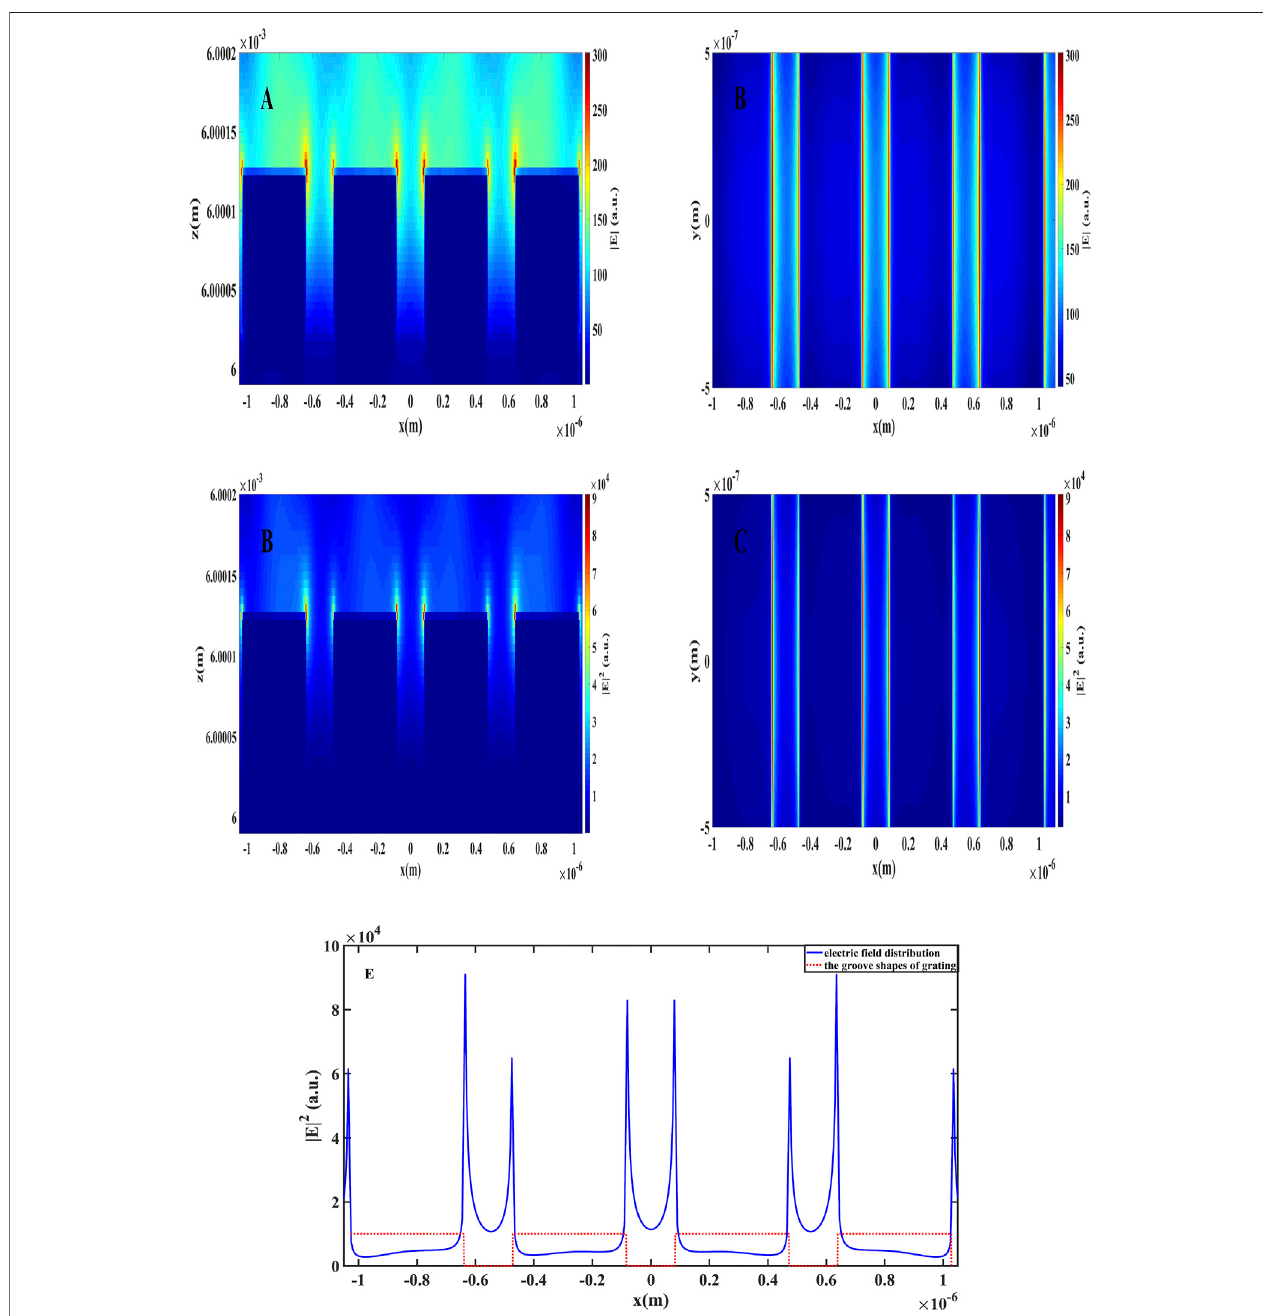
FIGURE 2 | Electric fi eld distribution of aluminum grating: (A) electric fi eld of the x-z plane (y = 0); (B) electric fi eld of the x-y plane (z = 6000125 nm); (C) |E| 2 distribution of the x-z plane; (D) |E| 2 distribution of the x-y plane (z = 6000125 nm); and (E) |E| 2 distribution in the x direction (y = 0 nm, z = 6000125 nm).